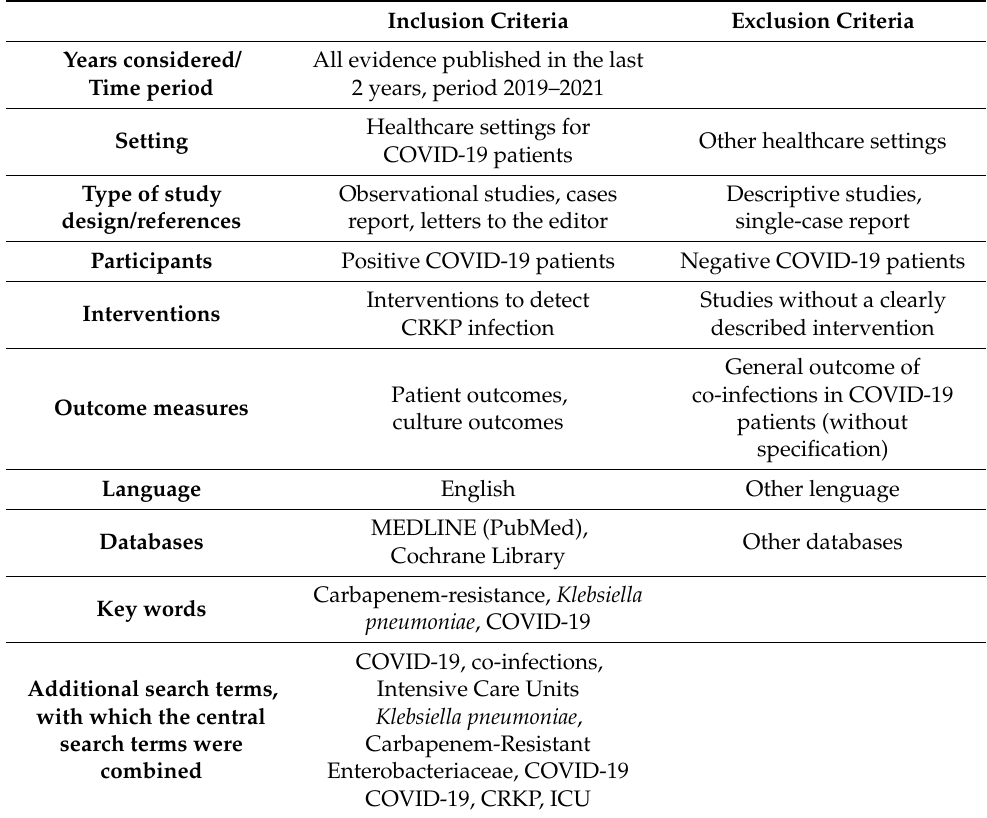
Table 1. Inclusion and exclusion criteria, search